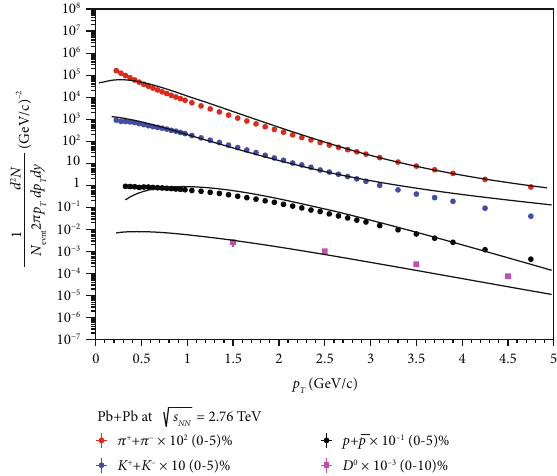
Figure 1: The transverse momentum spectra of ( π + + π − ), ( K + + K − ), ( p + (cid:1) p ), and D 0 mesons versus p for most central Pb+Pb collisions ffiffiffiffiffiffiffiffi p T = 2 : 76 TeV . Symbols are experimental data points [56, 57], at s NN and lines are the model results from equations (24) and